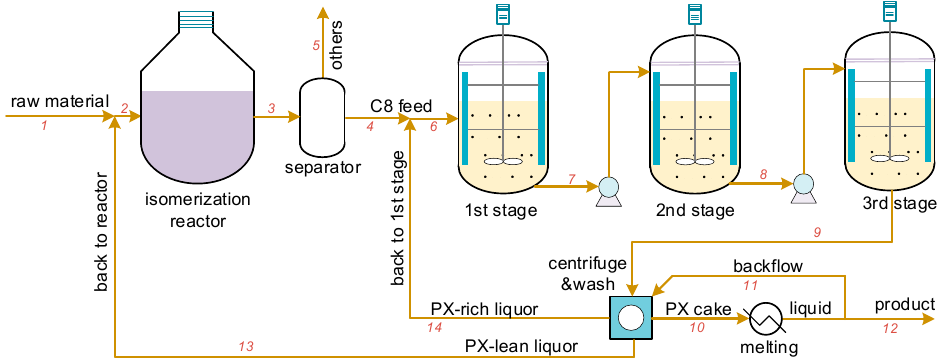
Figure 2. The three-stage PX suspension crystallization separation process, where 1-14 are the streams and were used for process optimization in Section 4.2.